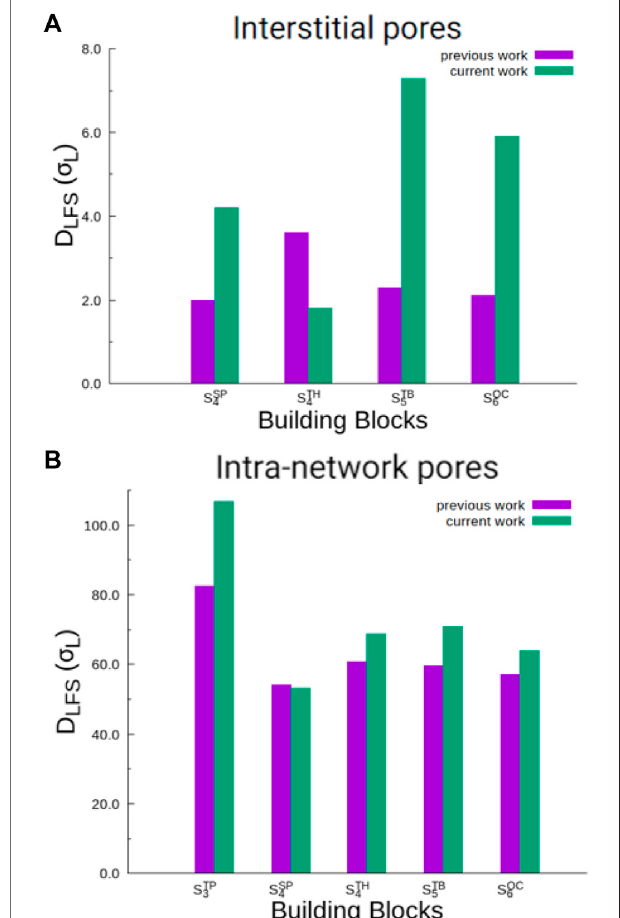
FIGURE 7 | A comparison of interstitial pore diameters [panel (A) ] and intra-network pore diameters [panel (B) ], computed based on data from this study and our previous work on charged lobed particles [27]. Data are shown for only those particle types which form interstitial or intra-network pores in both studies. In Supplementary Figure S7 , we also present pore diameters for self-assemblies of all particle types at all conditions from this